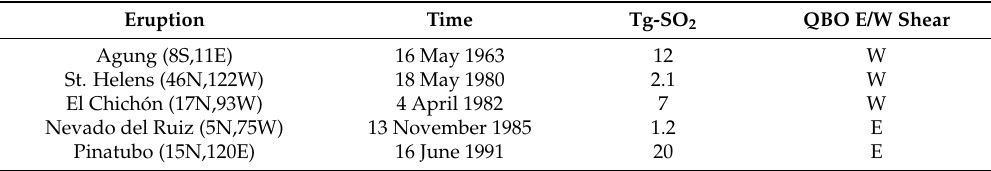
Table 1. Major volcanic eruptions considered in the present study, with the adopted amounts of the injected SO 2 and indication of the QBO E/W shear at the eruption time and following months. Eruption Time Tg-SO 2 QBO E/W Shear Agung (8S,11E)